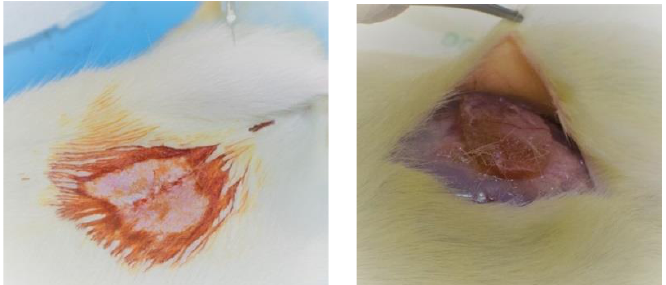
Figure 3. Silicon implant treated with dexamethasone – moment of extraction of the implant with no capsular contracture.